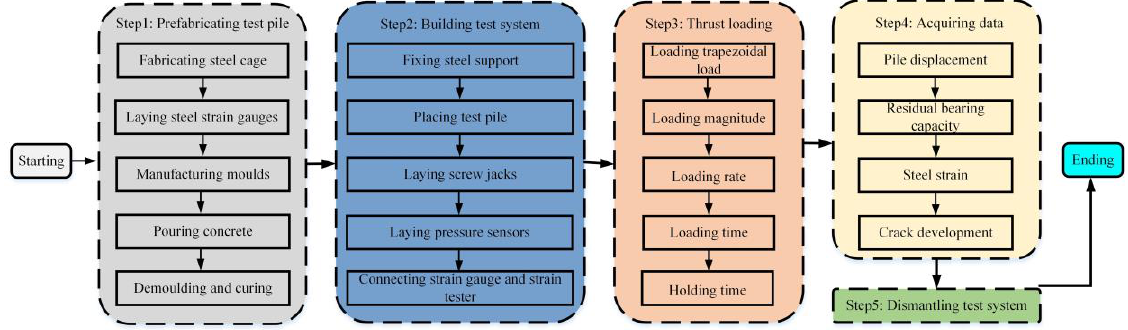
Figure 10. Experimental procedures.